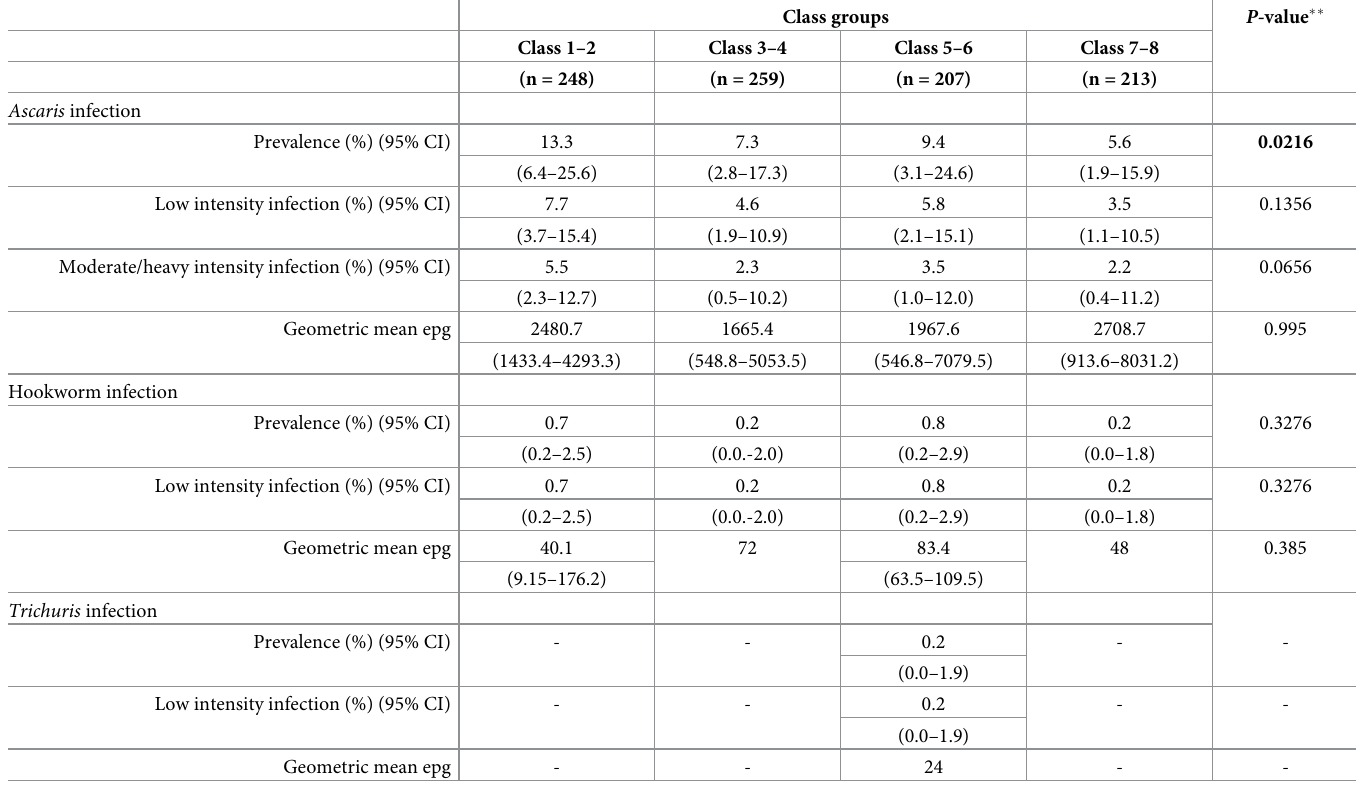
� All point estimates and CIs are weighted based on the proportion of sub-Divisional per Divisional population sizes. �� Across 4 class groups, and in bold fonts when <